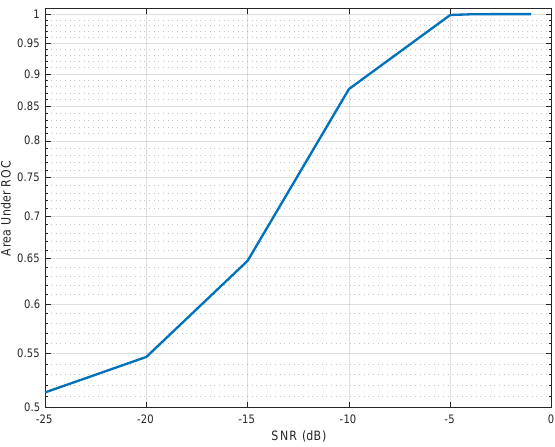
Figure 4. Area Under Curve for various SNR